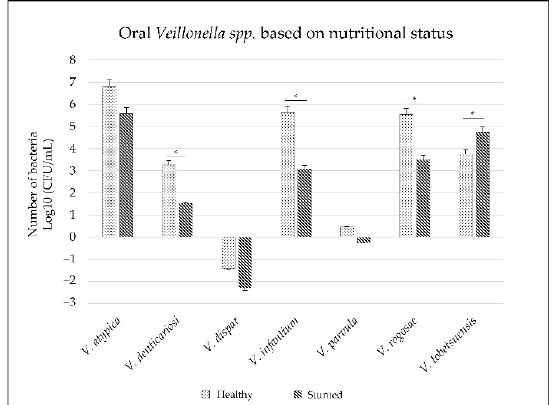
Figure 3. Number of oral Veillonella species based on the nutritional status. (*) Statistically significant ( p = 0.05).